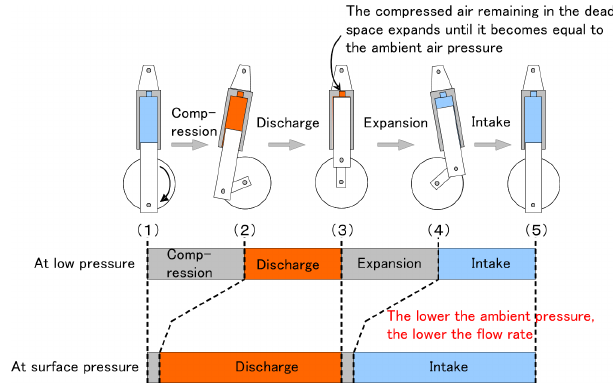
Figure 2. Piston pump operation during observation and the effect of dead space on pump